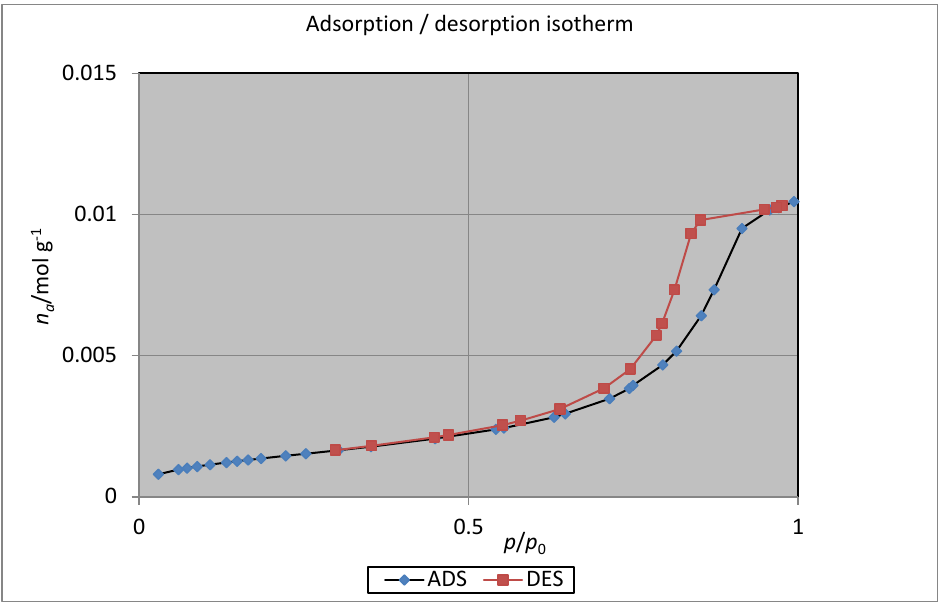
Fig. 13. The N adsorption-desorption 2